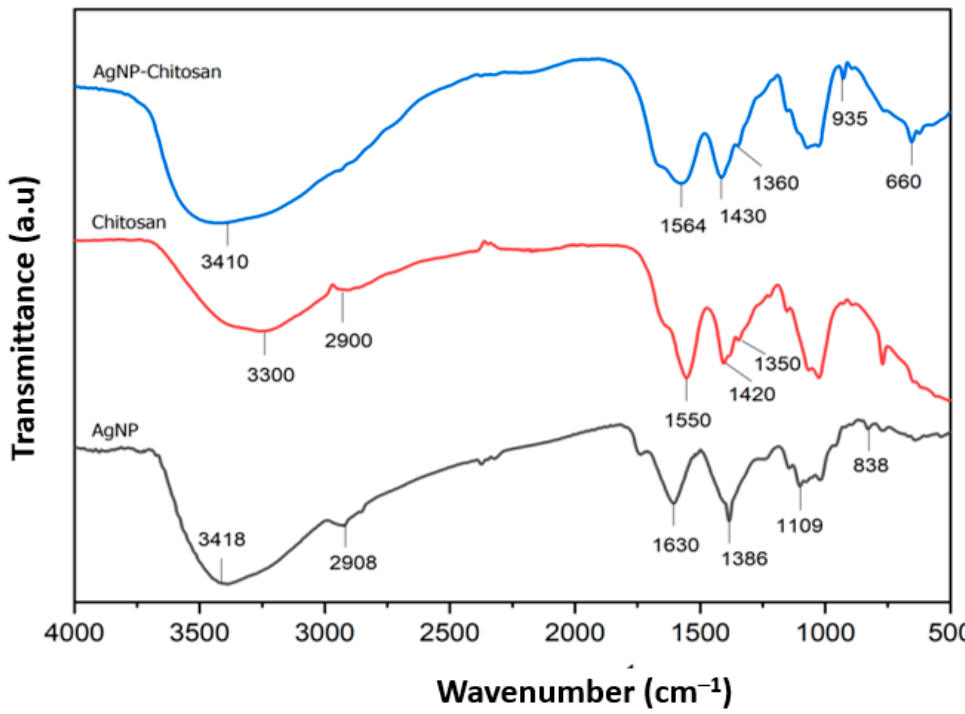
Figure 7. FTIR spectra of silver nanoparticles (black), chitosan (red), and silver nanoparticles coated with chitosan (AgNP-chitosan) (blue).